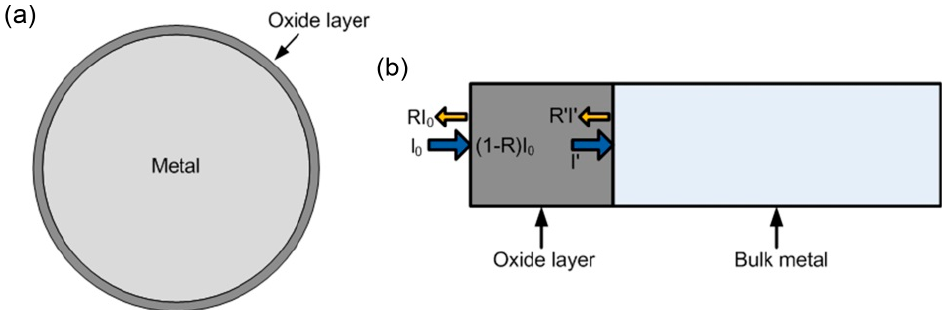
Figure 11. ( a ) Schematic diagram of the surface structure of steel powders and ( b ) Model of laser absorption at the surface of steel powders.